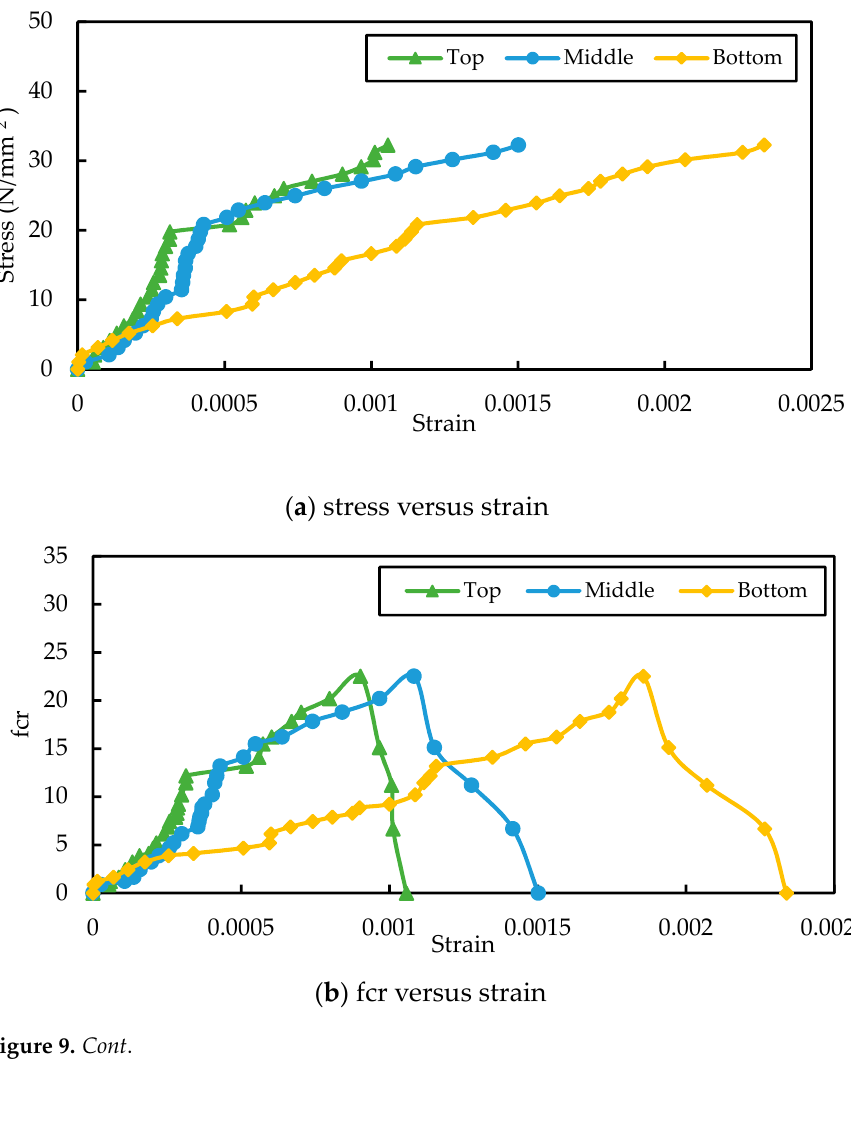
( b ) fcr versus strain